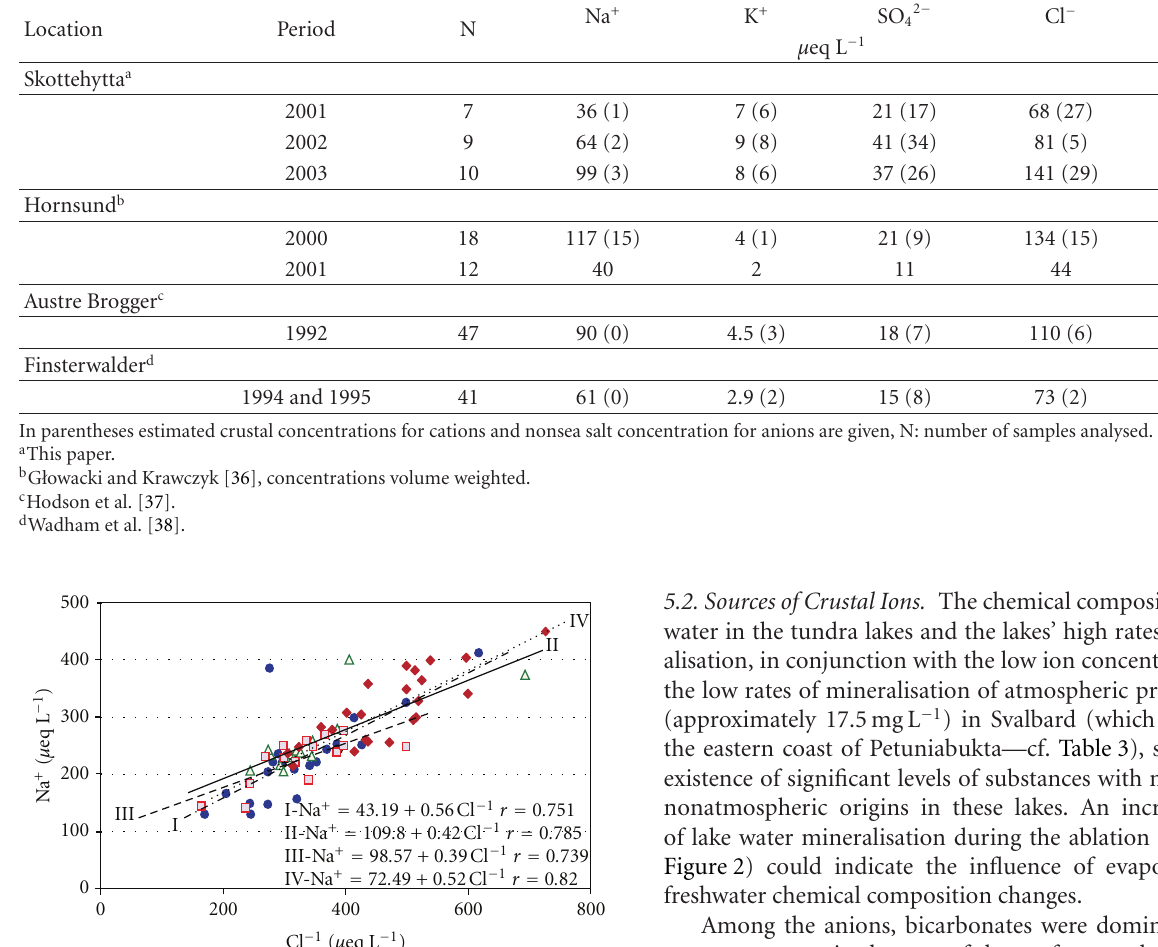
Table 3: Mean chemical characteristics of rain a,b and snow c,d in Svalbard.